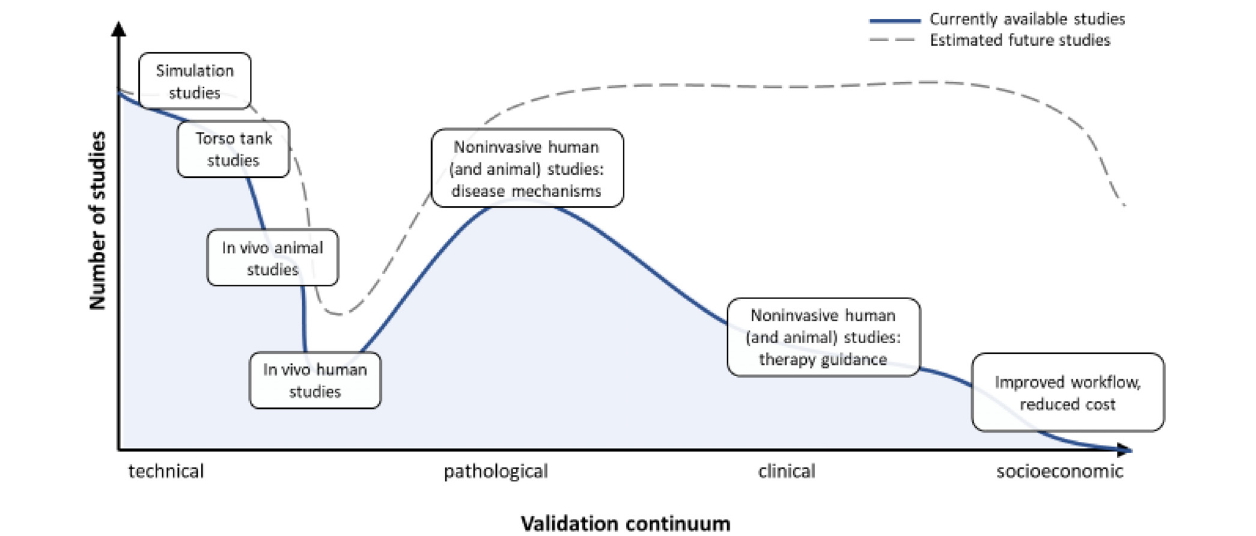
FIGURE 1 | Describes the validation continuum, from purely technical studies to pathological/clinical validation and socioeconomic benefit studies. Whereas the technical validation of ECGI is extensive, as is its use in disease mechanisms studies and validation of the true clinical benefit is still